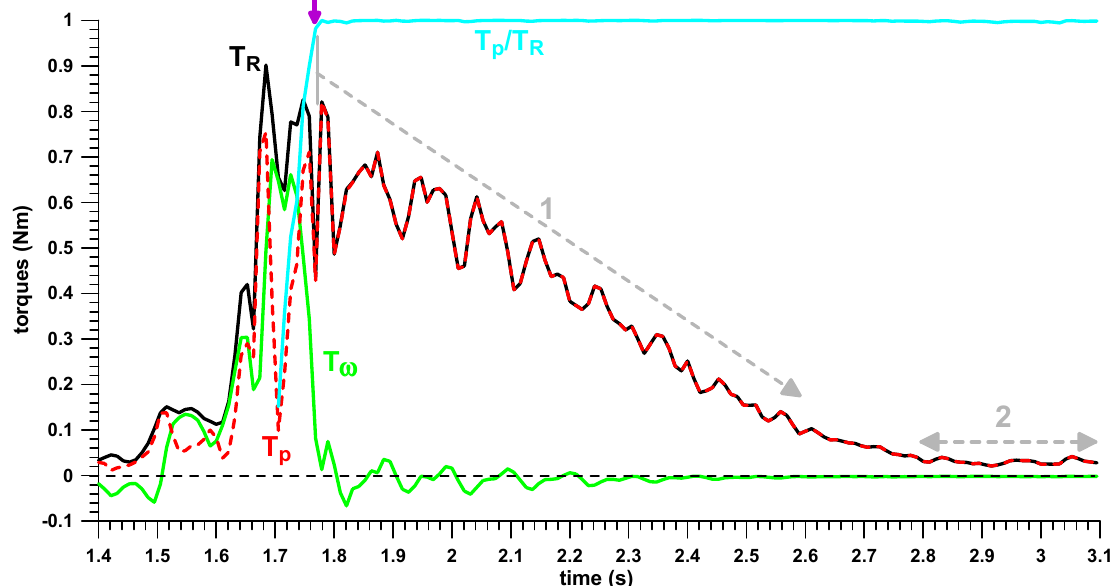
Figure 3. Torques acting on the Frisbee against time; T R = resultant torque, T ω = spin torque (that changes the magnitude of the spin rate), T p = precession torque (that moves the spin axis with respect to the solid Frisbee); the release point (small purple arrow) is identified by T p = T R and T p /T R = unity; ‘1 ′ = transient aerodynamic torques (decreasing); ‘2 ′ = steady-state aerodynamic torques.